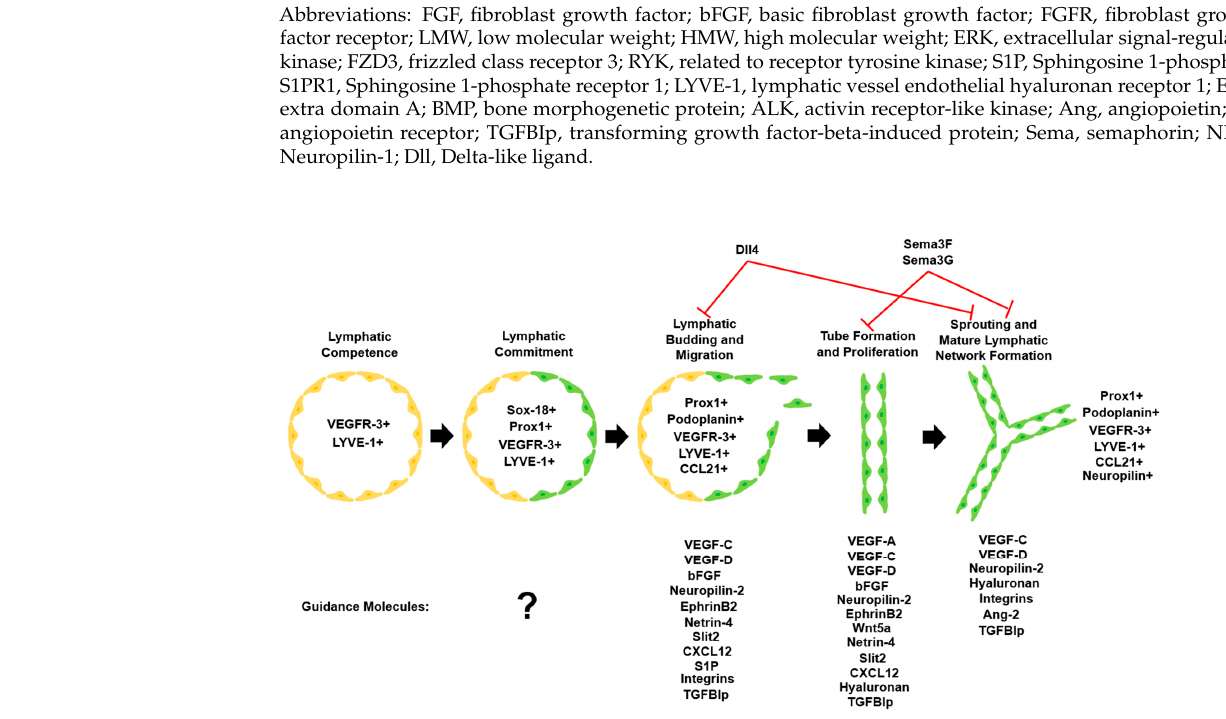
Figure 2. Lymphatic vascular system commitment and development. Upon commitment to the lym- phatic lineage, LECs undergo migration, proliferation, and sprouting to form the mature lymphatic network. Important lymphatic markers that are detectable at each step and various guidance mole- cules influence LEC fate during lymphangiogenesis [102]. Adapted with